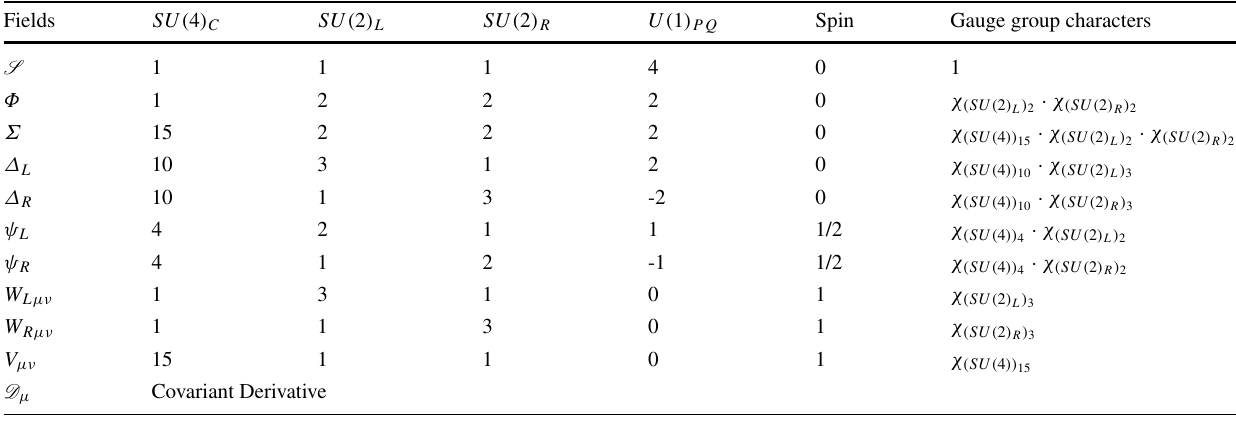
Table6 Pati-SalamModel:Quantumnumbersoffieldsunderthegauge groups, their spins and gauge group characters. Since the model only containsfieldshavingspins-0,-1 / 2,and-1,therelevantLorentzcharac- ters are the ones given in Eq. (109). Here, U ( 1 ) PQ appears as a global